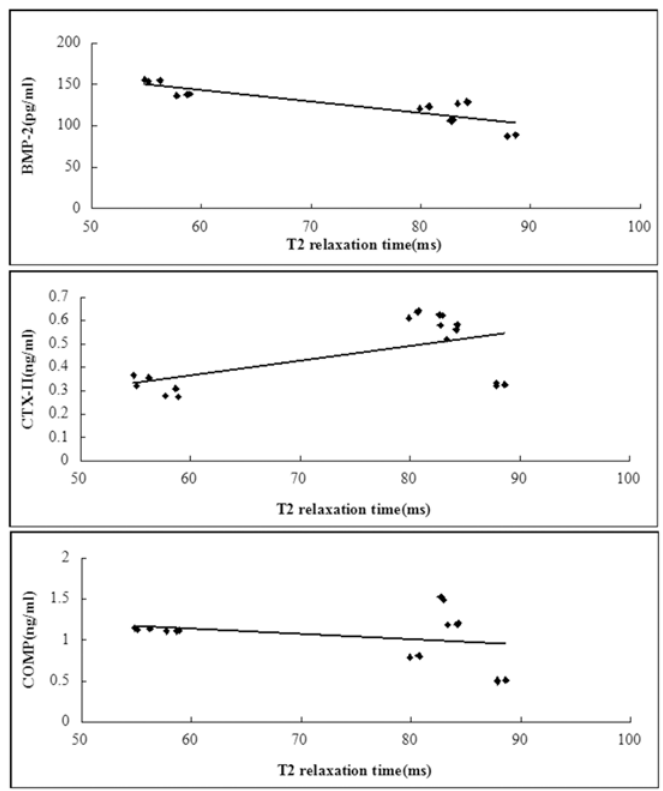
Fig 12. Scattergrams plotting individual serum biomarker concentration against T2 relaxation time values. For T2 relaxation times, there was a linear relationship with BMP-2 and CTX-II, except COMP(A, R 2 = 0.71, P < 0.001; B, R 2 = 0.32, P = 0.014; C, R 2 = 0.07, P = 0.305). N =